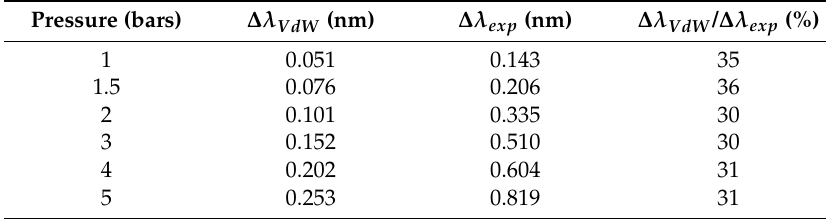
Table 2. The summary of the FWHM of the van der Waals broadening compared with the experimental FWHM of the six experimental spectra of the H- β line in a helium plasma considered in this paper.